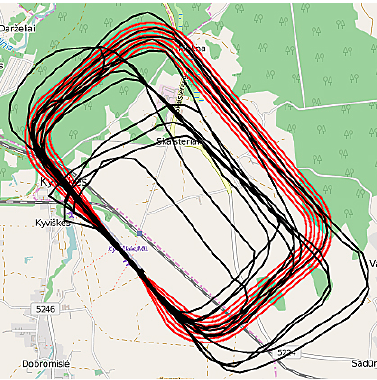
Fig. 9. Flight circuit model on the map with 100, 200 and 300 m width of tunnels and real flight trajectories